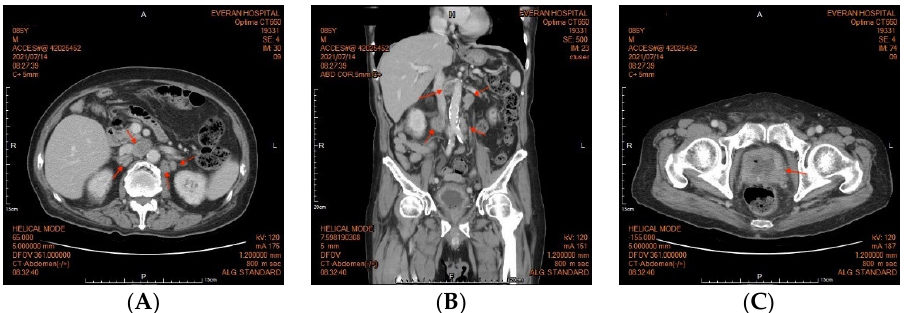
Figure 1. ( A ) Abdominal computed tomography (CT) revealed multiple lymph node enlargement at the paraaortic area (arrowhead). ( B ) Sagittal view of the abdomen CT. ( C ) Abdominal CT of the pelvis revealed a prostate gland with heterogenous density.